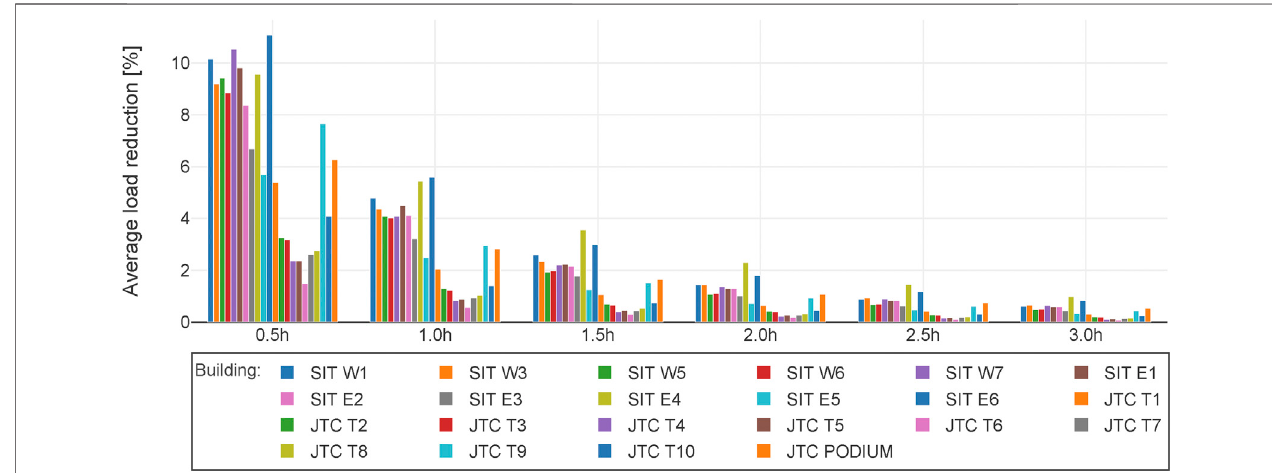
FIGURE 9 | Average load reduction potential per building.